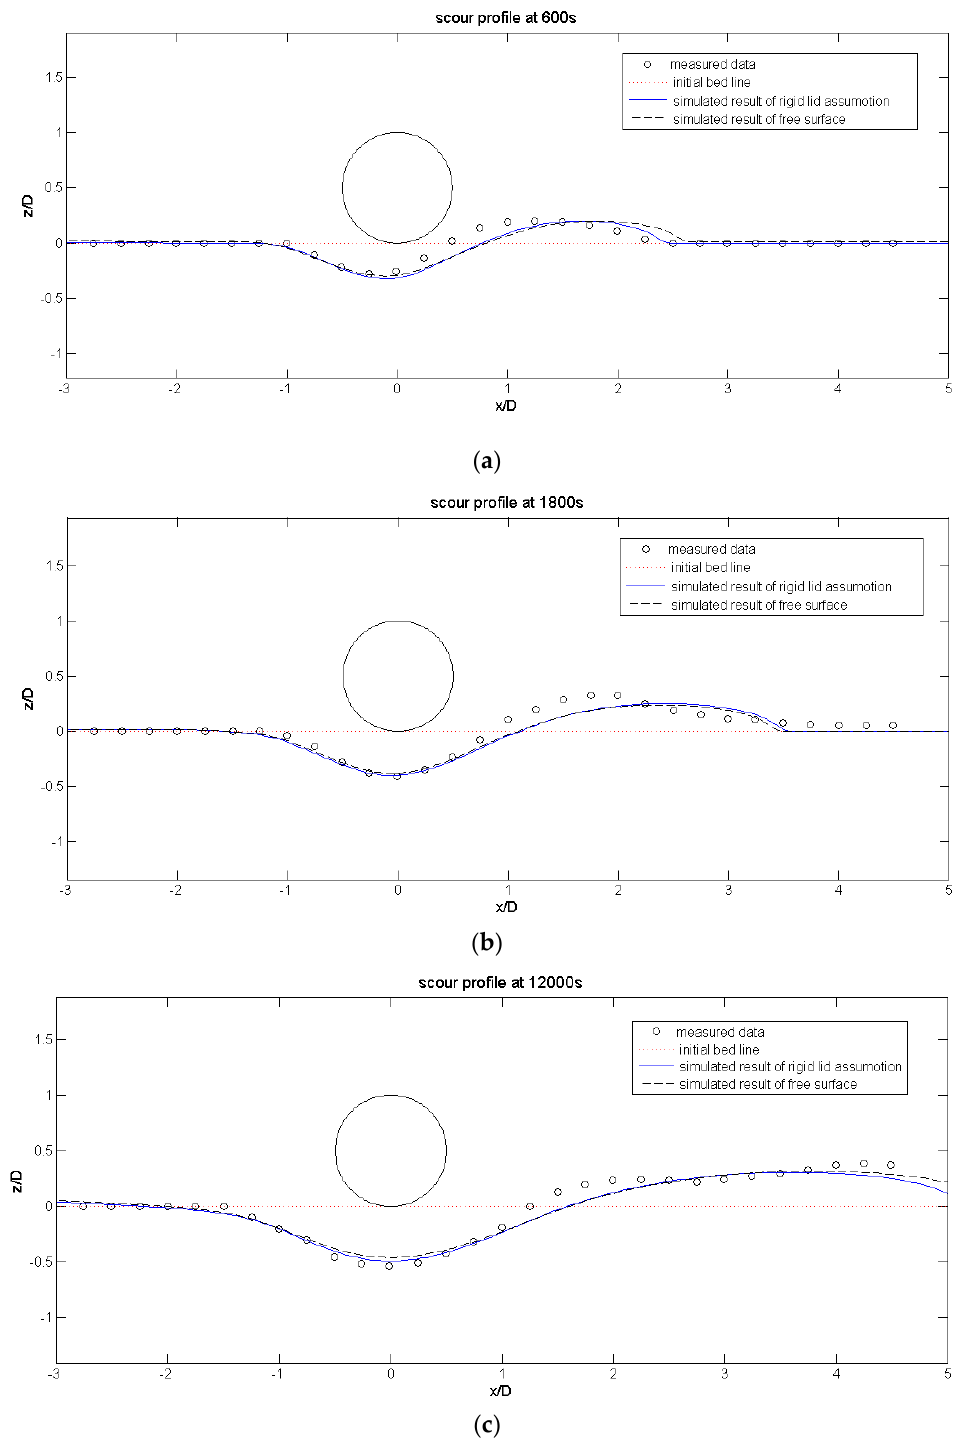
Figure 15. The scour profile of the free surface model and rigid lid assumption at different times in the case of Fr = 0.187, ( a ) T = 600 s; ( b ) T = 1800 s; ( c ) T = 12,000 s.